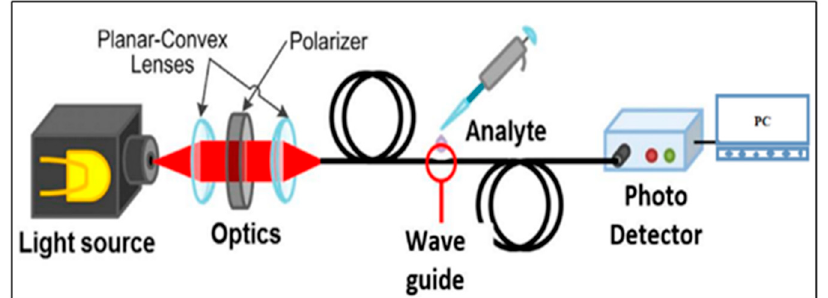
Figure 1. Schematic diagram of plastic optical fiber- (POF) based sensor.